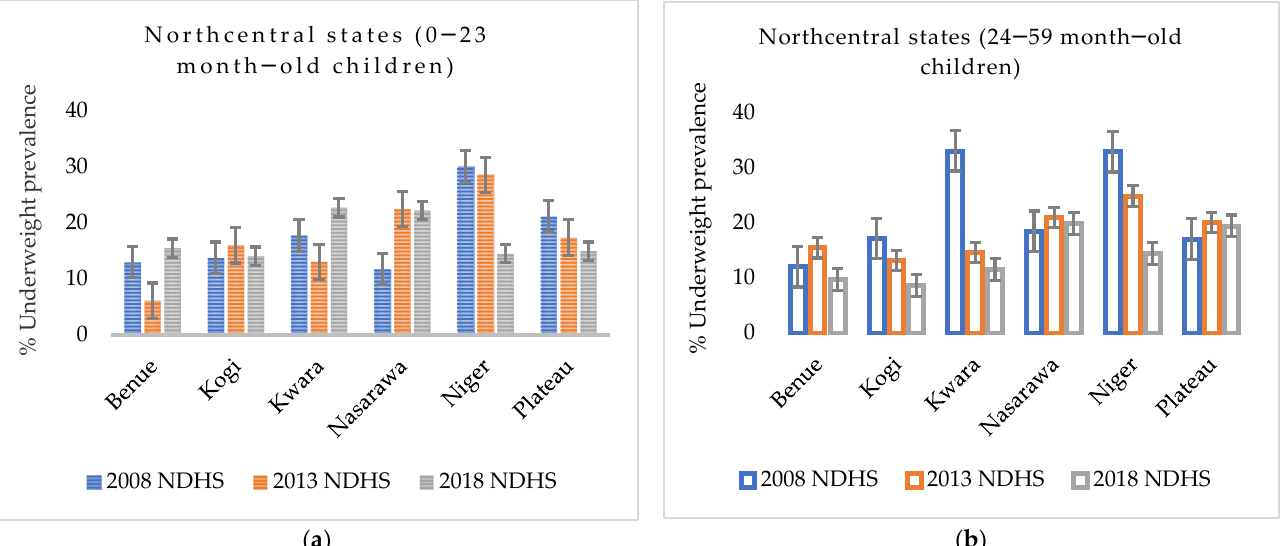
Figure 2. ( a ) Trends in prevalence of underweight among 0–23-month-old children from 2008 to 2018 Nigeria Demographic and Health Survey (NDHS), with a 95% confidence interval by north-central states; ( b ) trends in prevalence of underweight among 24–59-month-old children from 2008 to 2018 NDHS, with a 95% CI by northcentral states.